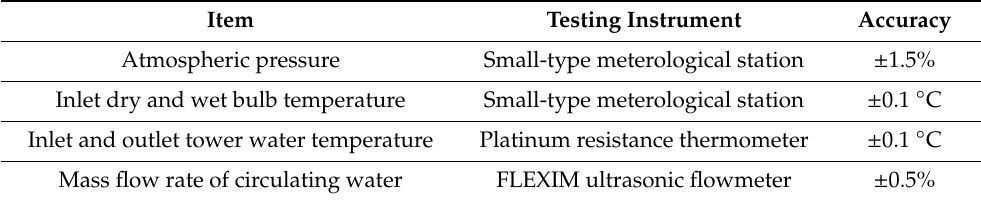
Figure 4. Sectional view of collecting basin mearing point. Table 3. Testing